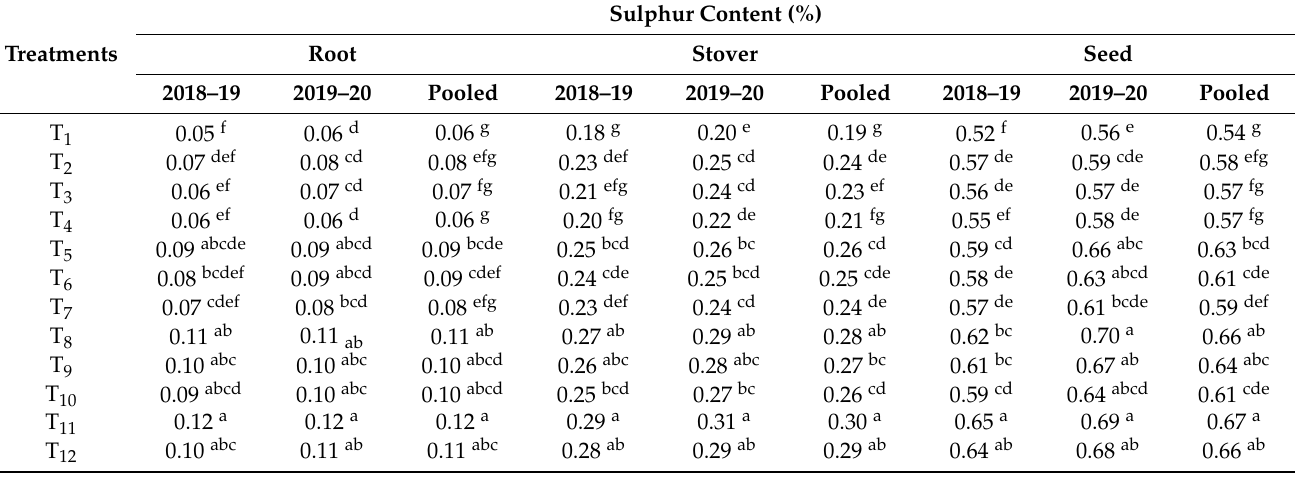
Table 3. Sulphur content of root, stover, and seed as influenced by the seed biopriming and varied levels of S fertilization in